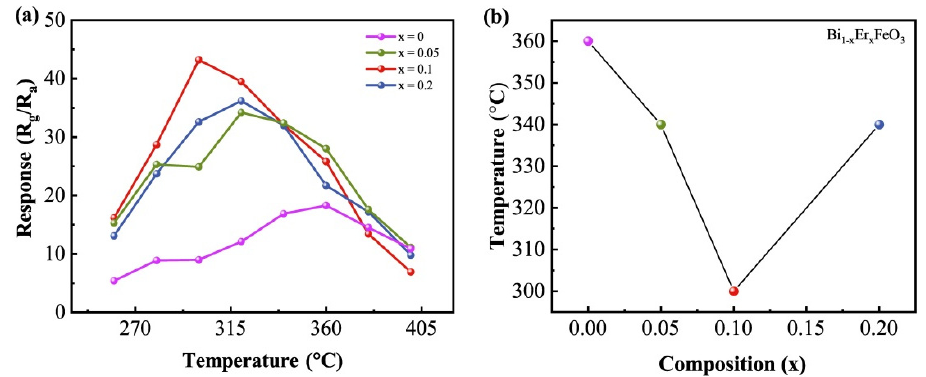
Figure 5. ( a ) Temperature dependence of response of Bi 1 − x Er x FeO 3 to 100 ppm acetone. ( b ) The optimal operating temperature as a function of Er content.